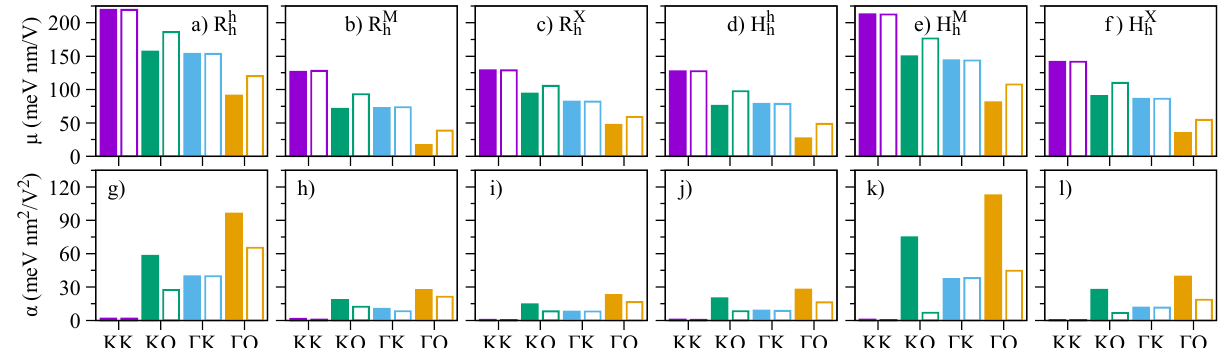
Figure 11. Calculated values of the electric dipole moments for ( a ) R h , ( b ) R M , ( c ) R X , ( d ) H h , ( e ) H M , h h h h h and ( f ) H X stackings. Calculated values of the polarizabilities for ( g ) R h , ( h ) R M , ( i ) R X , ( j ) H h , ( k ) H M , h h h h h h and ( l ) H X stackings. The x-axis indicates the type of dipolar excitons (see Figure 1g. The values h originating from c M/Q − (c M/Q + ) are shown with colored (open) boxes. To validate the symmetry-based selection rules of the direct interlayer excitons dis- cussed in Section 4.1, we present the dipole matrix elements computed within DFT in Figure 12. All the non-zero values match exactly the symmetry-based arguments discussed in Section 4.4. Generally, the dipole matrix elements decrease for increasing values of the electric field, with the exception of the p , which slightly increases for increasing elec- c M + ,v W tric field, reflecting the impact of the atomic registry on the wave functions of van der Waals heterostacks. Furthermore, the spin-dark optical transitions discussed in terms of symmetry in Section 4.1 are also present here. The momentum operator that enters the dipole matrix element (Equation (4)) does not flip spin, and therefore this transition is optically bright only if the 2-component spinors are mixed, which is indeed the case in our first-principles calculations with SOC. Our calculated values of the dipole matrix elements, along with their respective polarization, can be readily used to generate massive Dirac models for the dipolar excitons via the first-order perturbation within the k.p formalism, allowing the investigation of spin-dependent physics beyond the parabolic approximation [73,75].